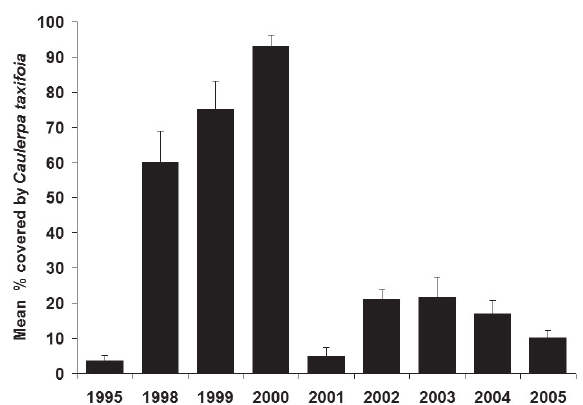
Fig . 1. – Mean cover of Caulerpa taxifolia (%) , from 1995 to 2005, in the Posidonia oceanica meadow at Cap Martin. error bars rep- resent ±